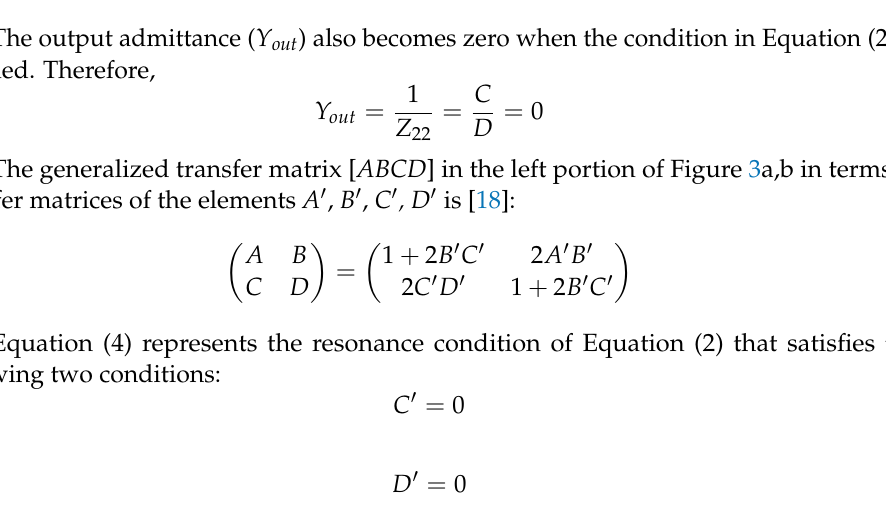
Figure 4. S 11 vs. S 21 frequency plot by loading conventional stub.